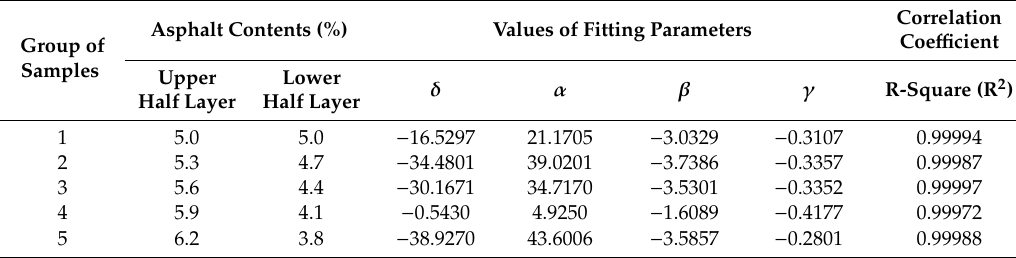
Table 8. The values of fitting parameters of Sigmoidal function by Origin (reference temperature: 20 ◦ C).